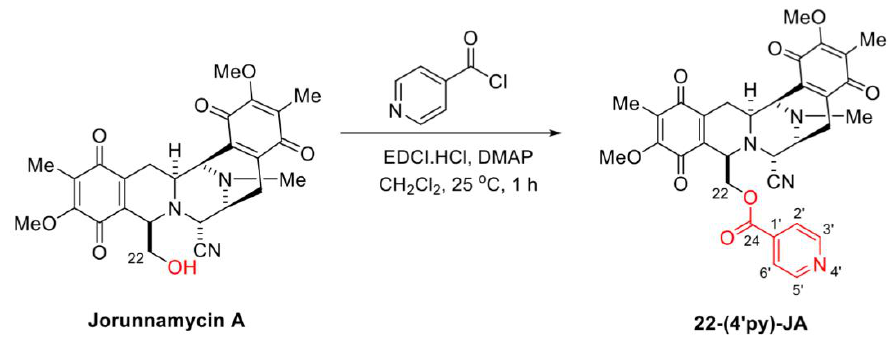
Figure 3. Semisynthesis of 22-(4 ′ py)-JA.